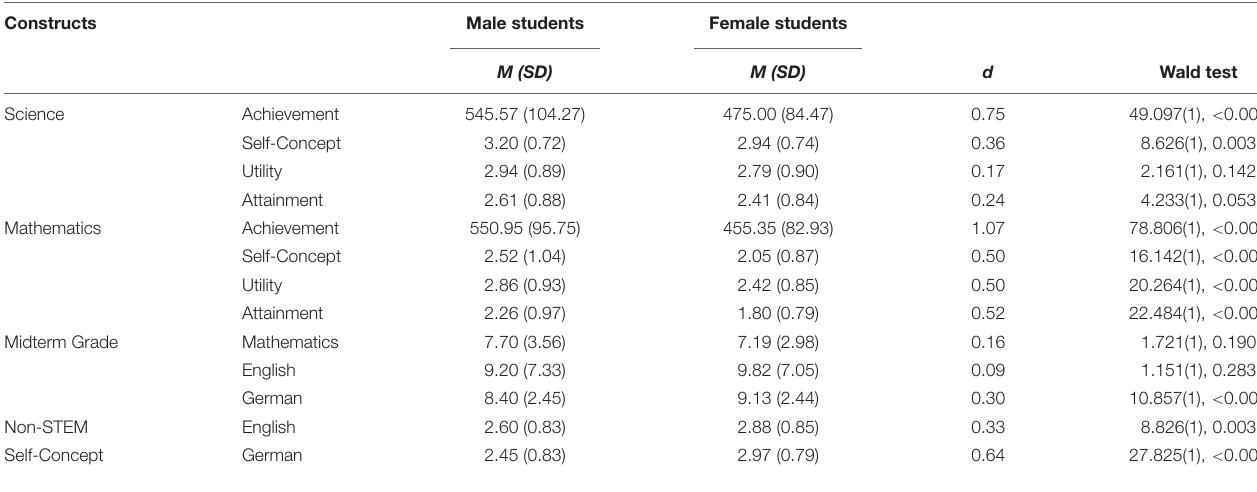
TABLE 1 | Means, standard deviation, effect sizes, and Wald test results for abilities, midterm grades, expectancy value variables in science and mathematics as well as English and German midterm grades and ability self-concept by gender.